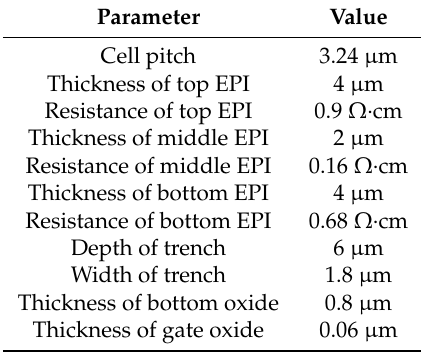
Table 1. The simulation parameters that were used for the triple-EPIs